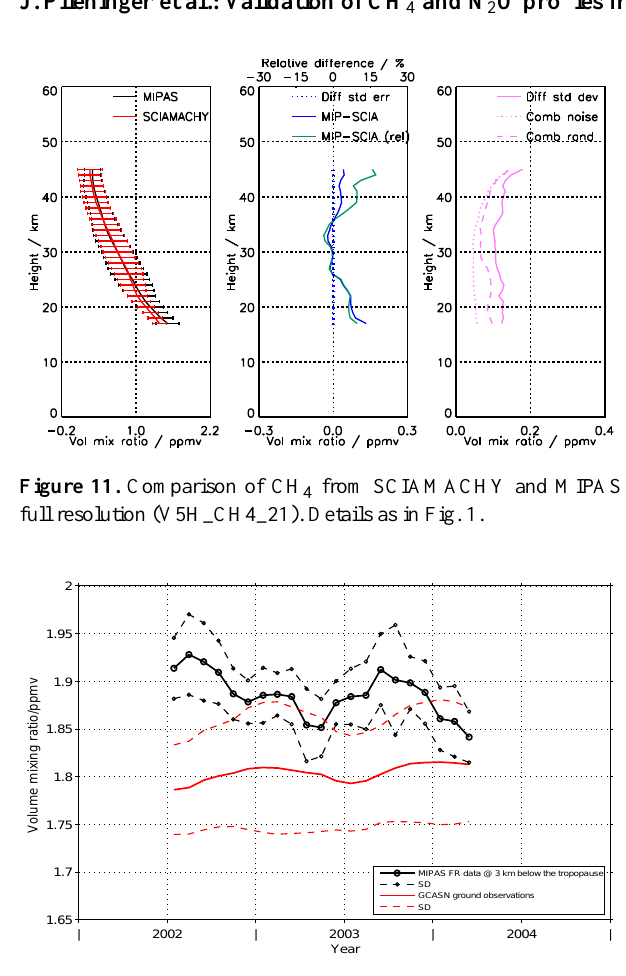
resolution period. Below 25 km the MIPAS mixing ratios are higher; the differences are below 0.1 ppmv. Between 25 and 35 km the agreement is very good, MIPAS showing slightly lower mixing ratios. Above 35 km MIPAS has slightly higher mixing ratios than SCIAMACHY. The combined errors are slightly underestimated.